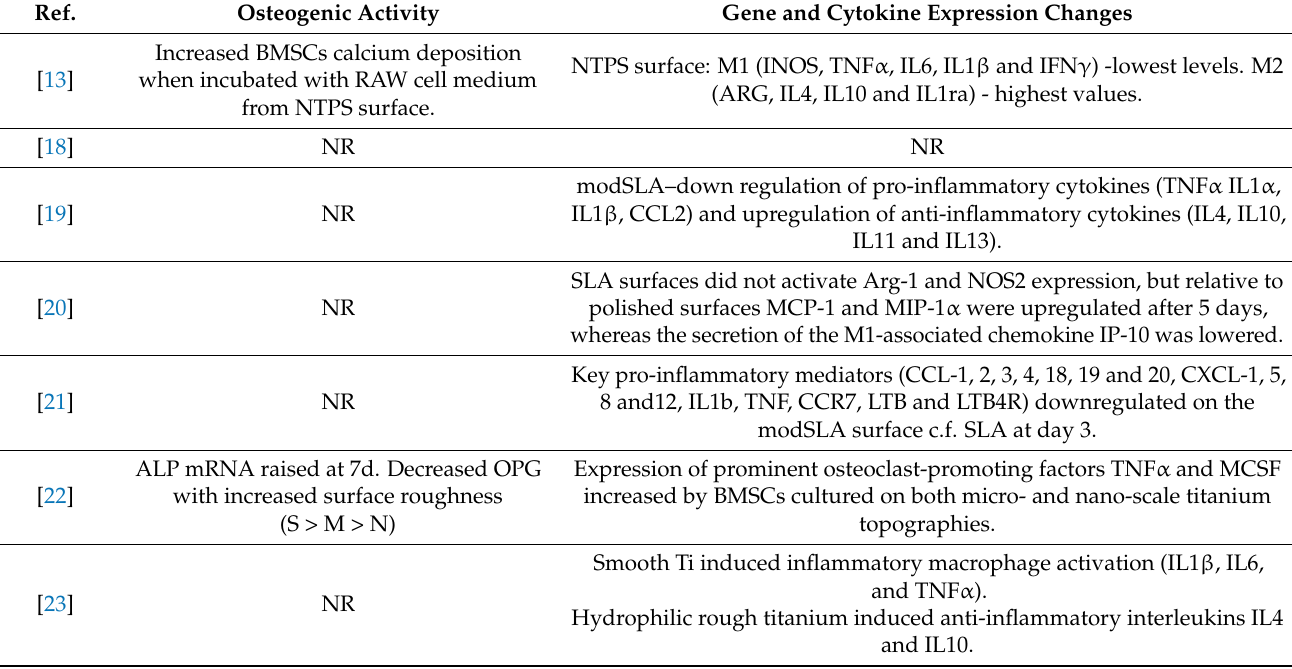
Table 5. Summary data (Osteogenic activity and Gene and Cytokine Expression changes) of studies included in review. (NR) not recorded in this